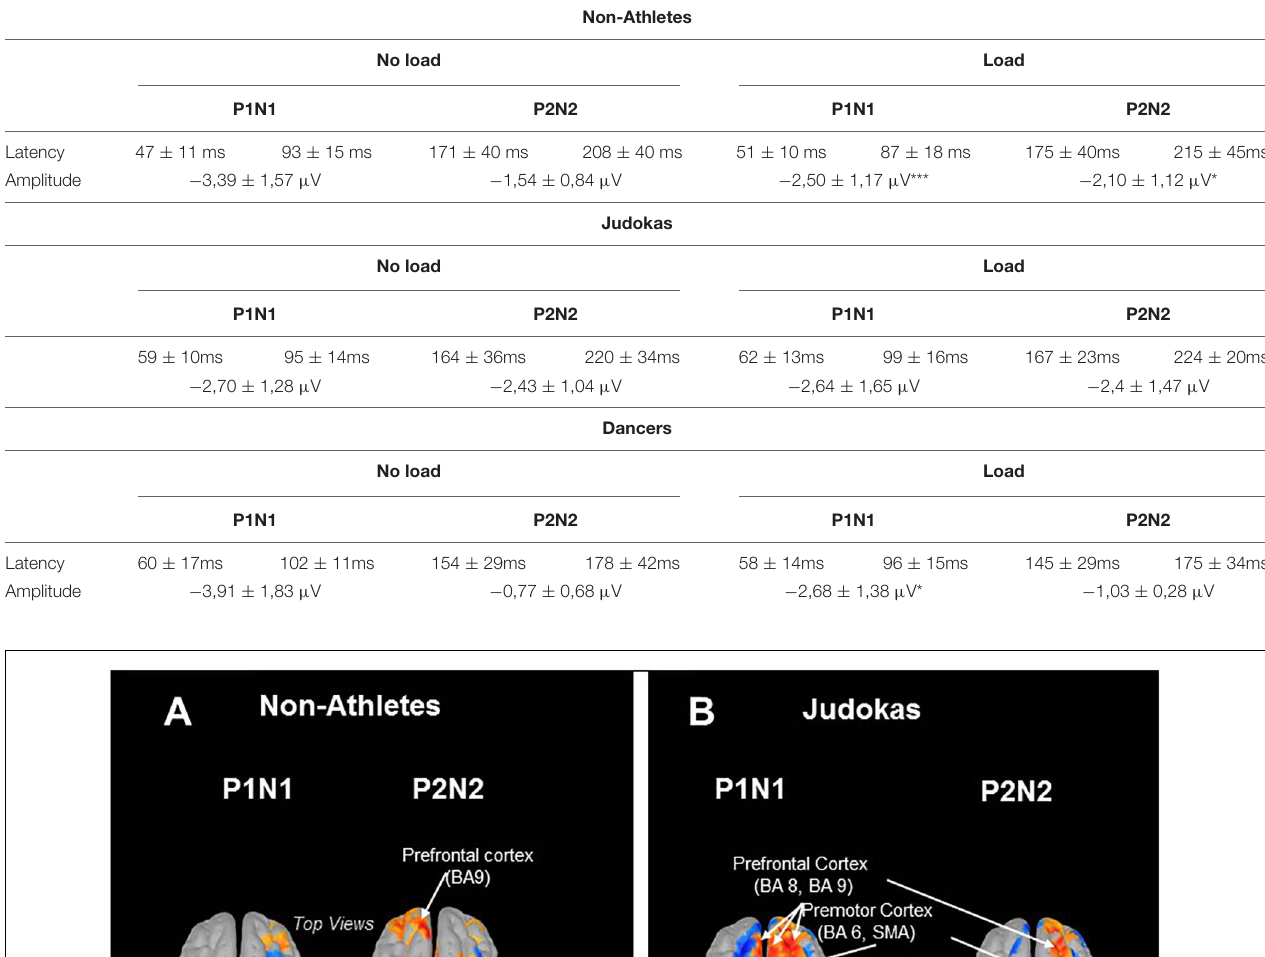
TABLE 1 | Latencies and amplitude of the early and late SEPs (mean and standard deviation) in control as compared with Loaded condition for Non-Athletes, Judokas and Dancers (*** p < 0.001, ** p < 0.01; * p < 0.05). Non-Athletes